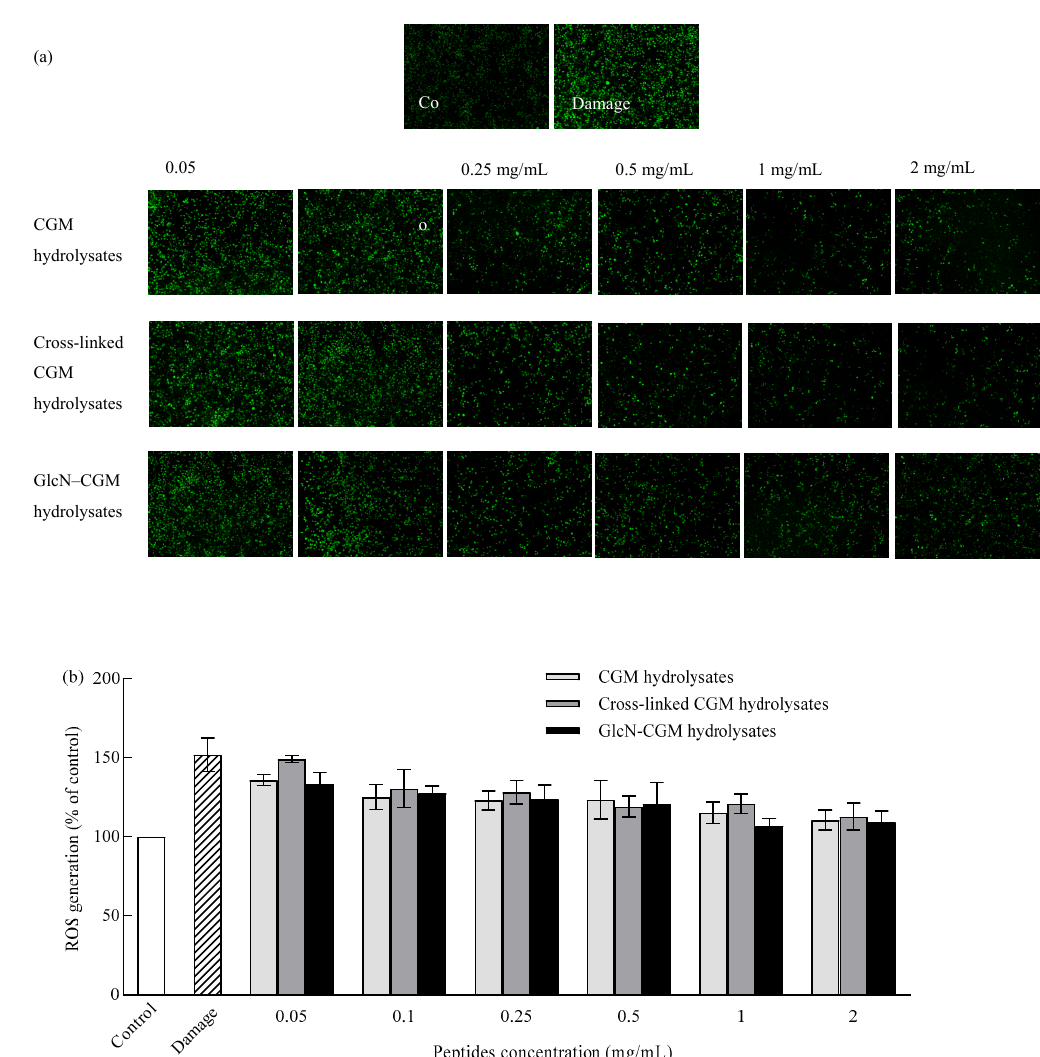
Figure 5. Intracellular reactive oxygen species (ROS) production in LO2 cells pretreated with CGM hydrolysates, cross-linked CGM hydrolysates or GlcN–CGM hydrolysates. ( a ) Photomicrographs of LO2 cells. Control: cells without any treatment; damage: cells treated with 3% ( v / v ) ethanol only. CGM hydrolysates, cross-linked CGM hydrolysates or GlcN–CGM hydrolysates were pretreated with the corresponding CGM hydrolysates samples for 4 h at 0.05 to 2 mg/mL, followed by 24 h ethanol exposure at 3% ( v/v ). The samples stained with 2 ′ ,7 ′ -dichlorofluorescein diacetate (DCFH-DA). ( b ) Intracellular ROS production values are expressed as the percentage of fluorescence intensity relative to the control. The values are expressed as means ± SD of at least three independent experiments.